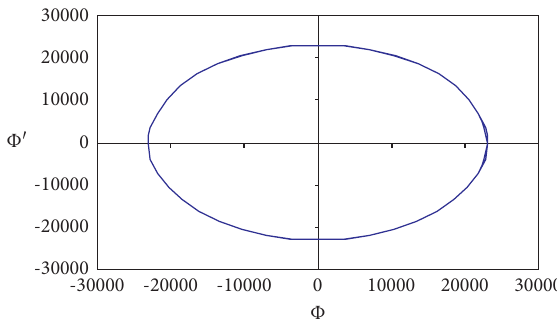
Figure 31: The stability phrase Φ ′ and Φ for case (iii) in Section 4.2.